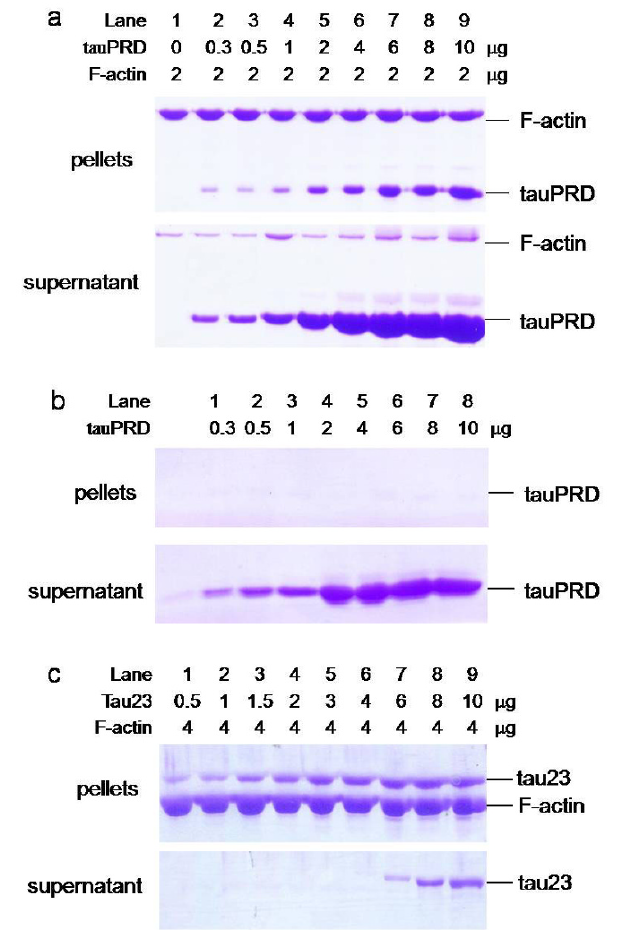
Figure 6 High speed co-sedimentation assay of tauPRD and F- actin . F-actin (at a constant concentration) was incubated with different concentrations of tauPRD (panel a), tauPRD alone (panel b) and tau (panel c) in the binding buffer without addition of extra NaCl at 37°C for 40 min and then centri- fuged (100,000 g, 4°C, 60 min). The pellet and supernatant were electrophoresed on 12% SDS-PAGE gels.